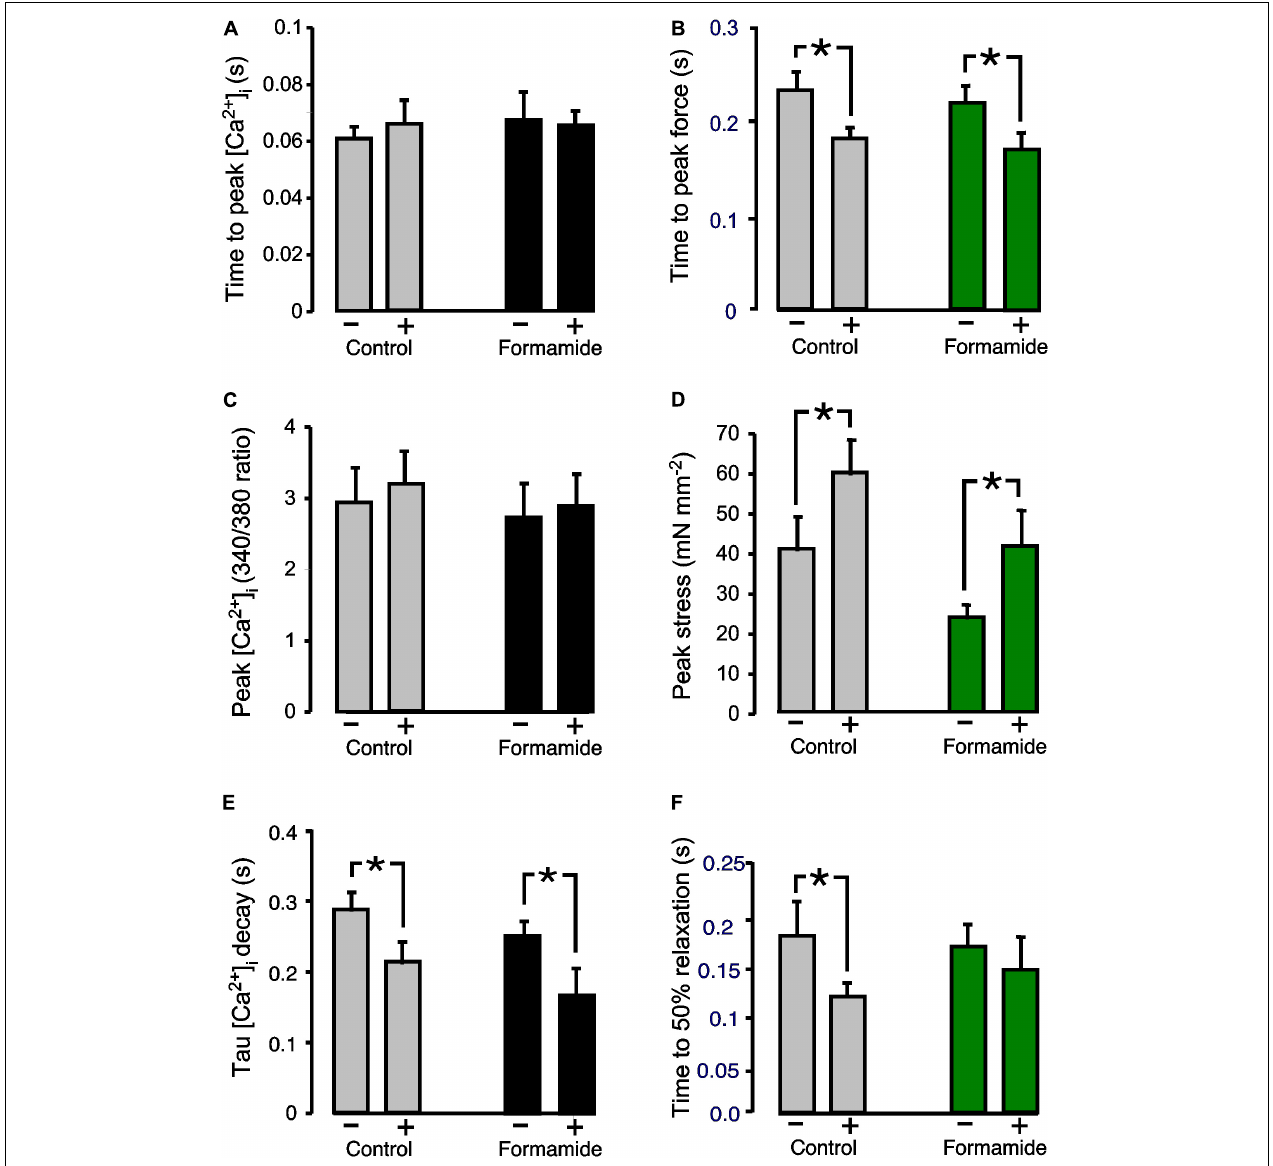
FIGURE 3 | Effect of formamide on response to ß-adrenergic stimulation. (A,C,E) Show Ca 2 + transient parameters before ( − ) and during ( + ) 1 µ M isoproterenol. (B,D,F) Show twitch force parameters before ( − ) and during ( + ) isoproterenol. Data are mean ± SEM. * P < 0.05. Two-way ANOVA followed by Sidak’s multiple comparisons test (Prism), n = 7 control and 8 formamide-treated